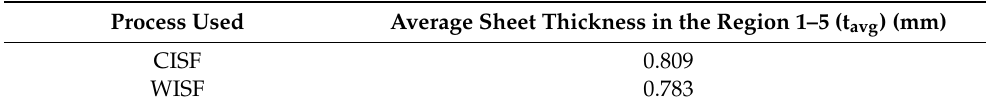
Figure 17. ( a ) Different regions for thickness measurement in formed cone, ( b ) measurement of sheet thickness by pointed-tip micrometer, and ( c ) thickness variation in different regions in CISF, WISF, and by sine law prediction. Table 12. Thickness distribution in the fabricated sheet of 6061 aluminum alloy in CISF and WISF. Process